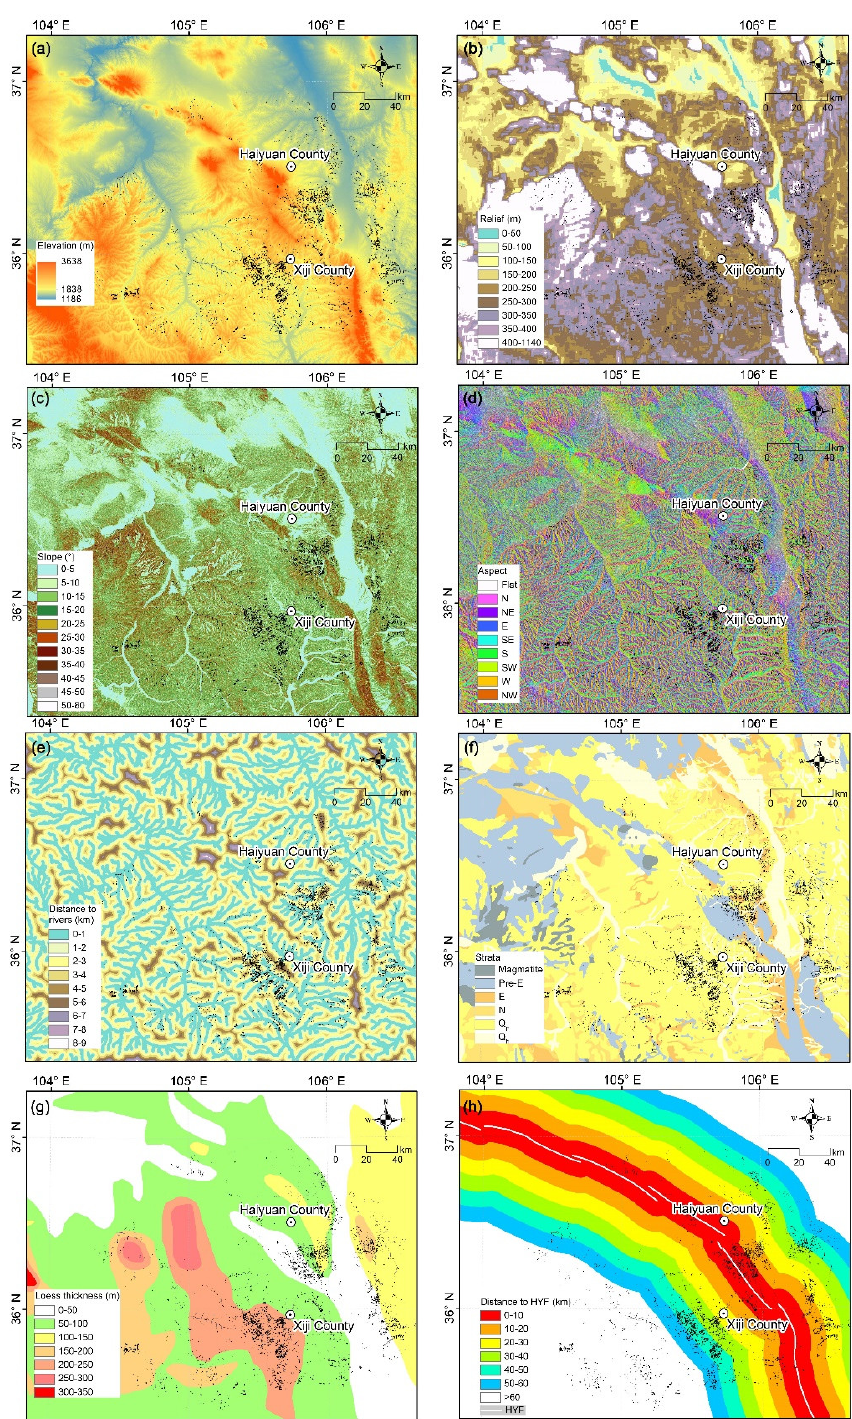
Figure 6. Factor maps used in analyzing the spatial distribution of damming landslides. Terrain factors: ( a ) elevation, ( b ) relief, ( c ) slope, ( d ) aspect, and ( e ) distance to rivers. Geological factors: ( f ) strata and ( g ) loess thickness. ( h ) Earthquake factor: distance to HYF. Terrace data were extracted from ALOS DEM (https://search.asf.alaska.edu, accessed on 2 November 2018). Strata data were obtained from a 1:200,000 geological map (http://dcc.ngac.org.cn/geologicalData/cn//geologicalData/details/doi/10.23650/data.A.2019.NGA120157.K1.1.1.V1, accessed on 2 May 2021). Location of HYF referred 1:4,000,000 scale of the active fault in China [42].